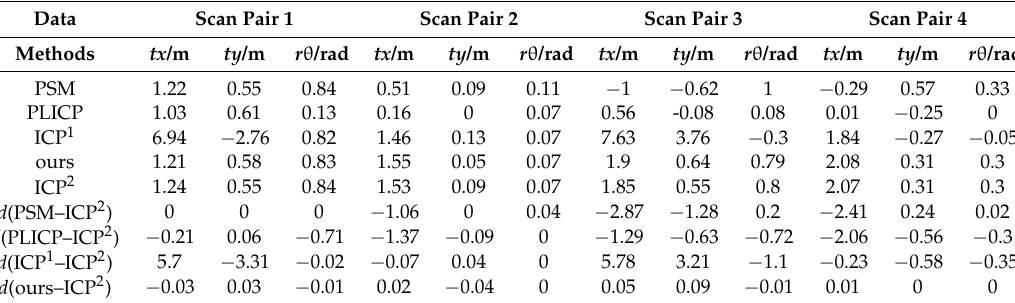
Table 2. Quantitative evaluation on dataset 2.